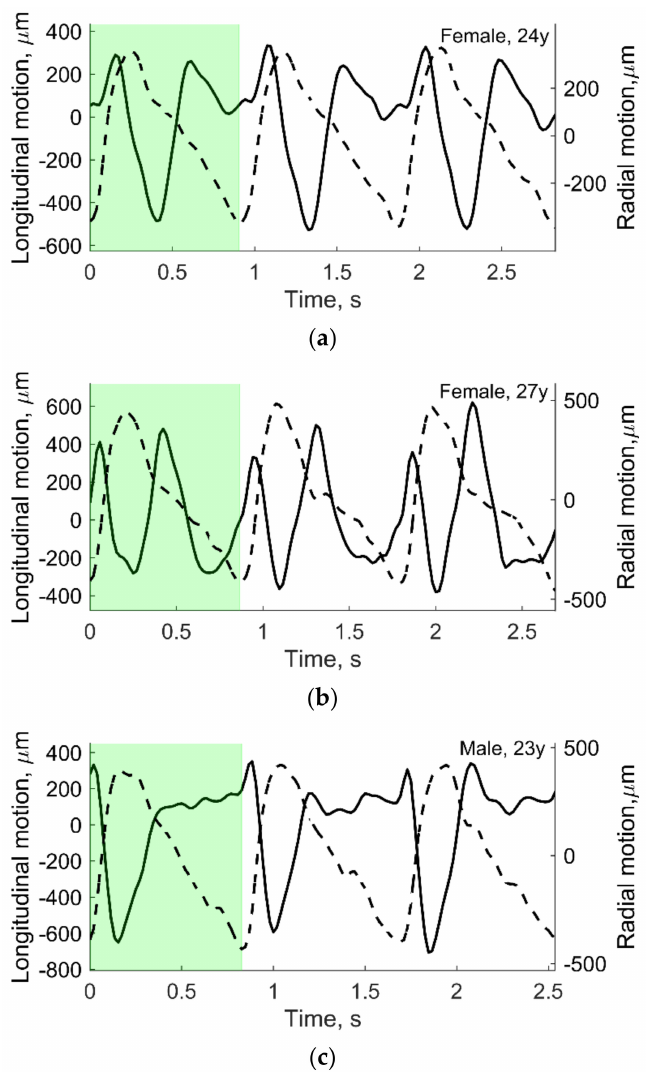
Figure 5. The processed in vivo radial (dashed line) and longitudinal (solid line) motions of CCA in three young subjects: ( a ) 24 year old female; ( b ) 27 year old female; ( c ) 23 year old male. Preselected periods (green shadowed area) were used to model artery and tissue motion. Adopted from